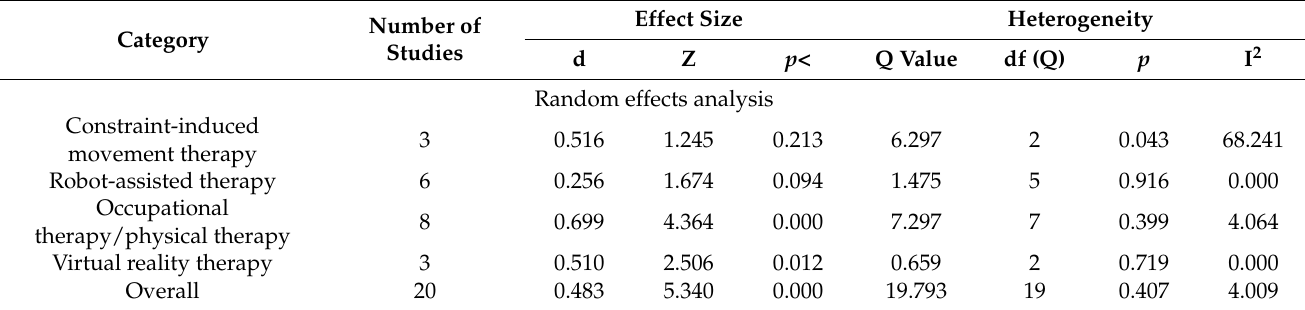
Table 3. Effect size of tDCS combined with